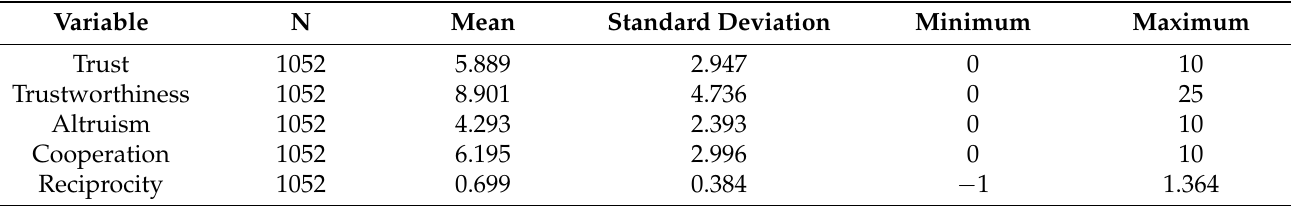
Table A2. Summary statistics of experimental